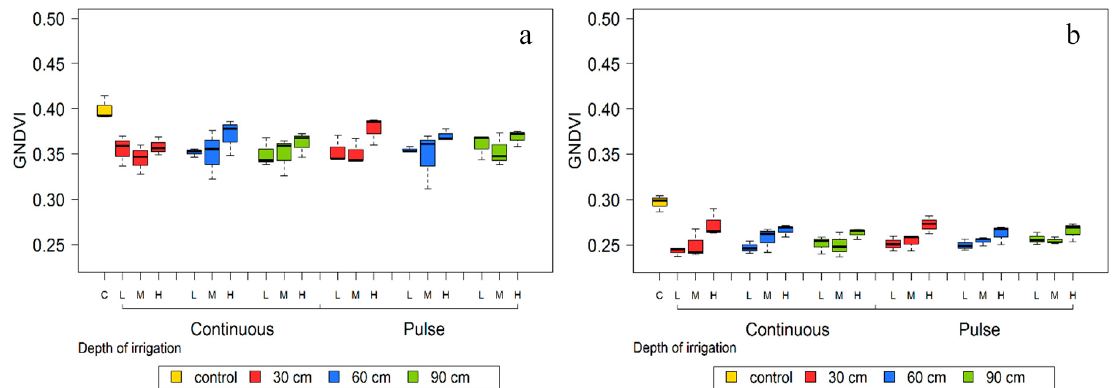
Figure 7. Green normalized difference vegetation index (GNDVI) data obtained at ( a ) 80 and ( b ) 44 DBH. In the boxplot, the upper and lower whiskers represent the maximum and minimum values, the upper and lower box borders represent the 75th and 25th percentile values, respectively, and the horizontal dark line indicates the median. C = control, 100% standard irrigation rate; L = low level of irrigation, 15%; M = medium level of irrigation, 30%; H = high level of irrigation, 60%.